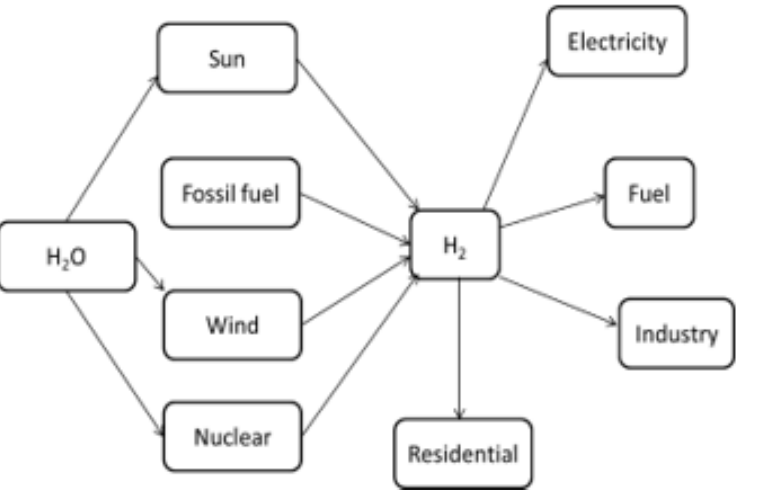
Figure 1. Web-diagram showing the primary energy sources for the production of hydrogen and its uses .